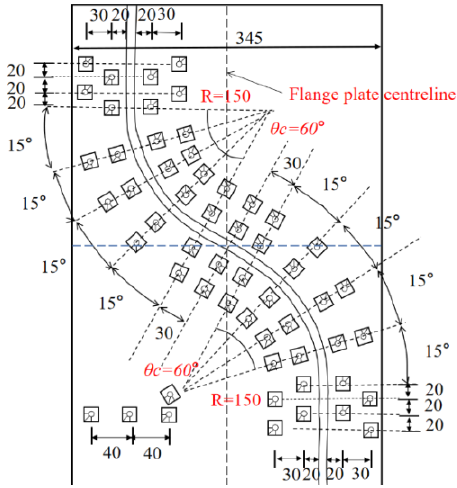
Figure 17. The layout of specimen strain sensor [26].